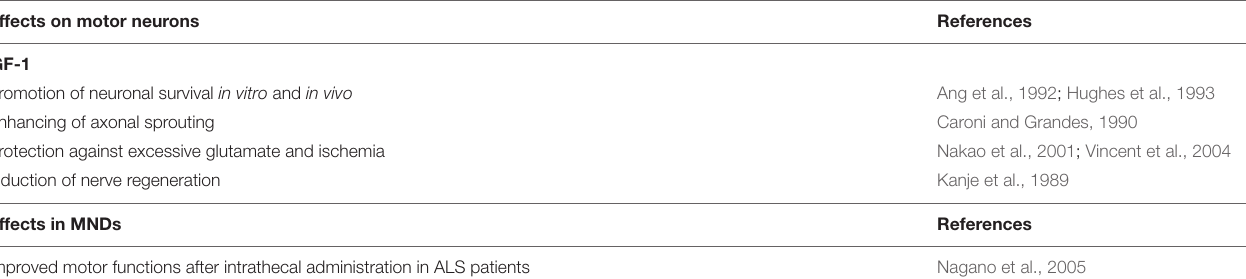
TABLE 1 | Effects of PACAP and IGF-1 on motor neurons and their role in